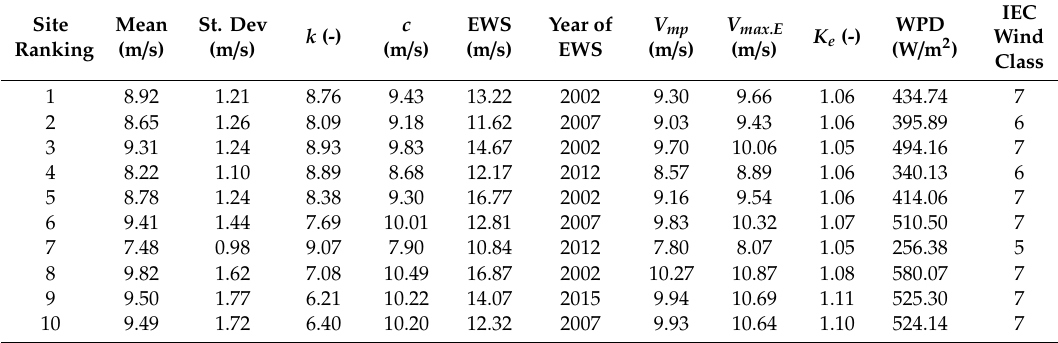
Table 3. Wind characteristics at newly proposed onshore wind farm sites (90 m height).